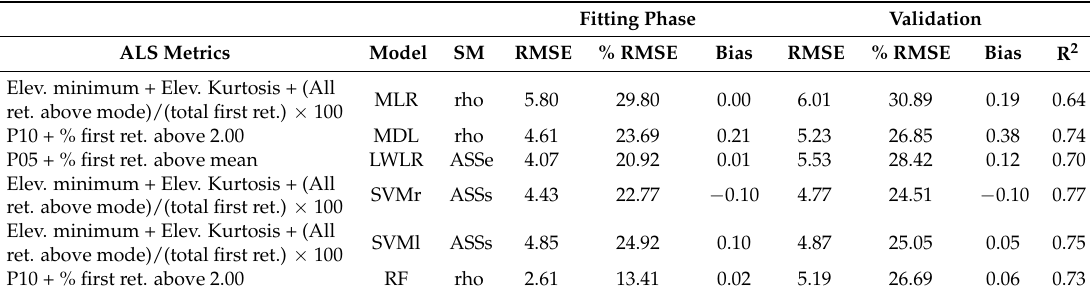
Table A4. Summary of the G models using 2011 ALS data. Validation results in terms of RMSE (m 2 ha − 1 ), %RMSE, and bias (m 2 ha − 1 ) and R 2 . SM refers to selection method; Step. stands for Stepwise both and forward; SVMr. refers to support vector machine with radial kernel; SVM l. refers to support vector machine with linear kernel; ret. refers to